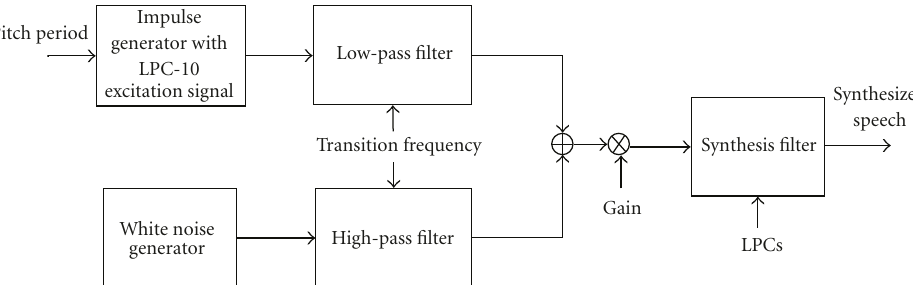
Figure 4: Block diagram of the adaptive dual-band synthesizer. Transition frequency controls cuto ff frequency of low-pass and high-pass filters.